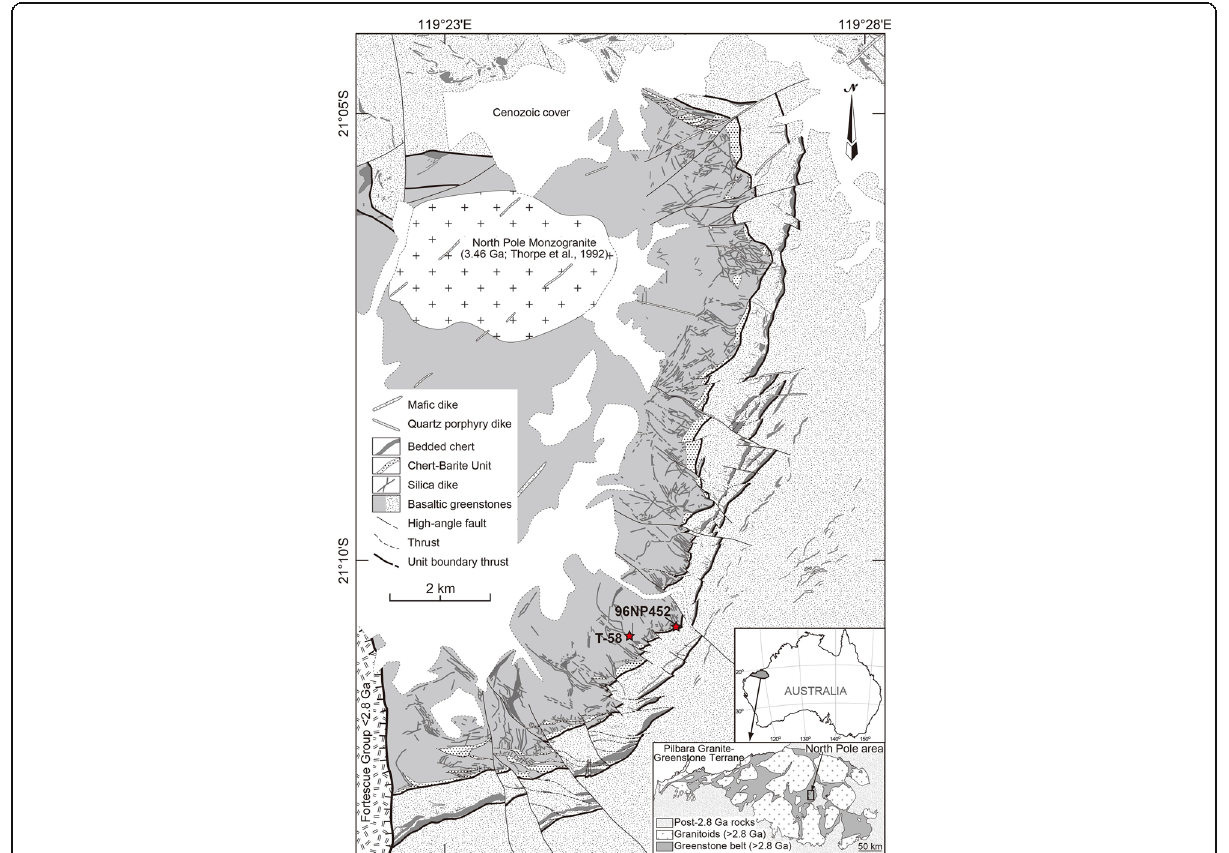
Fig. 1 Geologic map of the Dresser Formation in the North Pole area. The localities of the silica vein samples 96NP452 and T-58 are shown (modified from Kitajima et al.